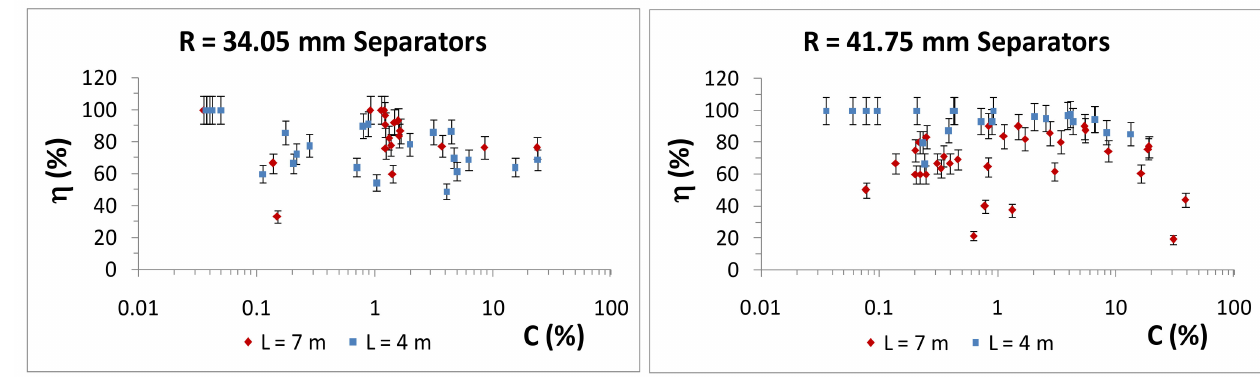
Figure 12. Relationship between the water concentration C (%) and the separation yield η (%) for the separators tested with different helix radiuses R (34.05 mm and 41.75 mm) and tube lengths L (4 and 7